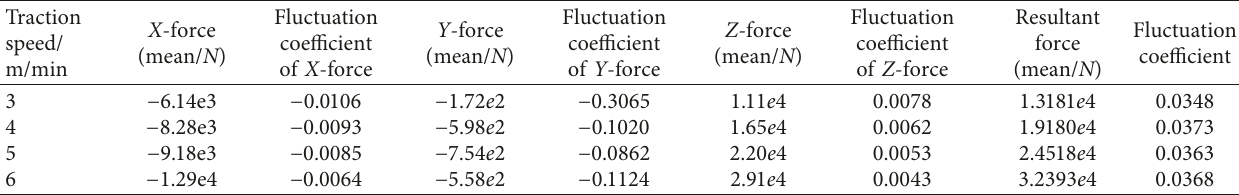
Table 5: The relationship between the traction speed and the three-directional force of the drum. Traction